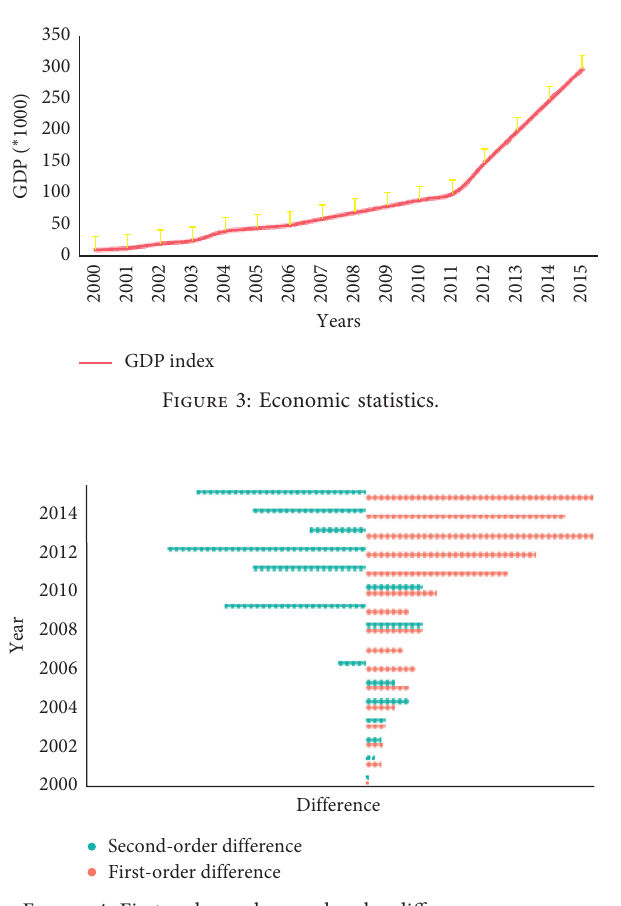
Figure 4: First-order and second-order difference sequence.